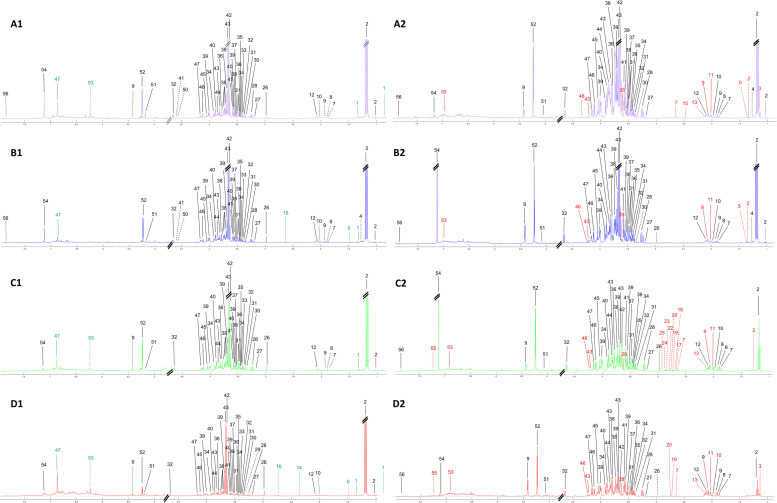
Median standard one-dimensional 1H NMR spectra of Dipterocarpus alatus at 2 (A), 7 (B), 15 (C) and 25 (D) years of leaf (1) and bark (2). Solid line indicates metabolites found in both leaf and bark at all ages, whereas dashed line indicates metabolites found in either leaf or bark. Green line indicates metabolites found in leaf only, whereas red line indicates metabolites found in bark only. Metabolite list is present in S1 Table in S1 File.